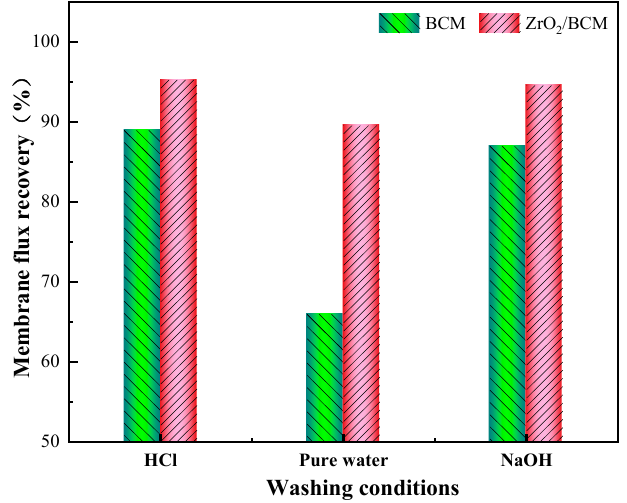
Figure 12. The flux recovery rate of BCM and 1 wt.%-ZrO 2 /BCM.